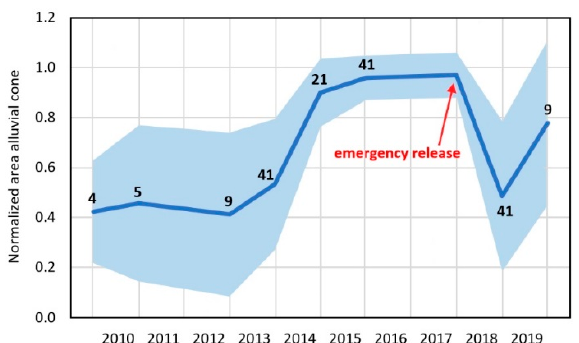
Figure 13. Evolution in the normalized area of alluvial cones—calculated as a fraction of the maximum extent of the alluvial cone—up to RK150. A total of 41 alluvial cones were mapped at different time steps according to the (non-continuous) availability of high-resolution satellite images in Google Earth (no data were available for hydrologic years 2011, 2016 and 2017). The number of studied alluvial cones is indicated for each time step.